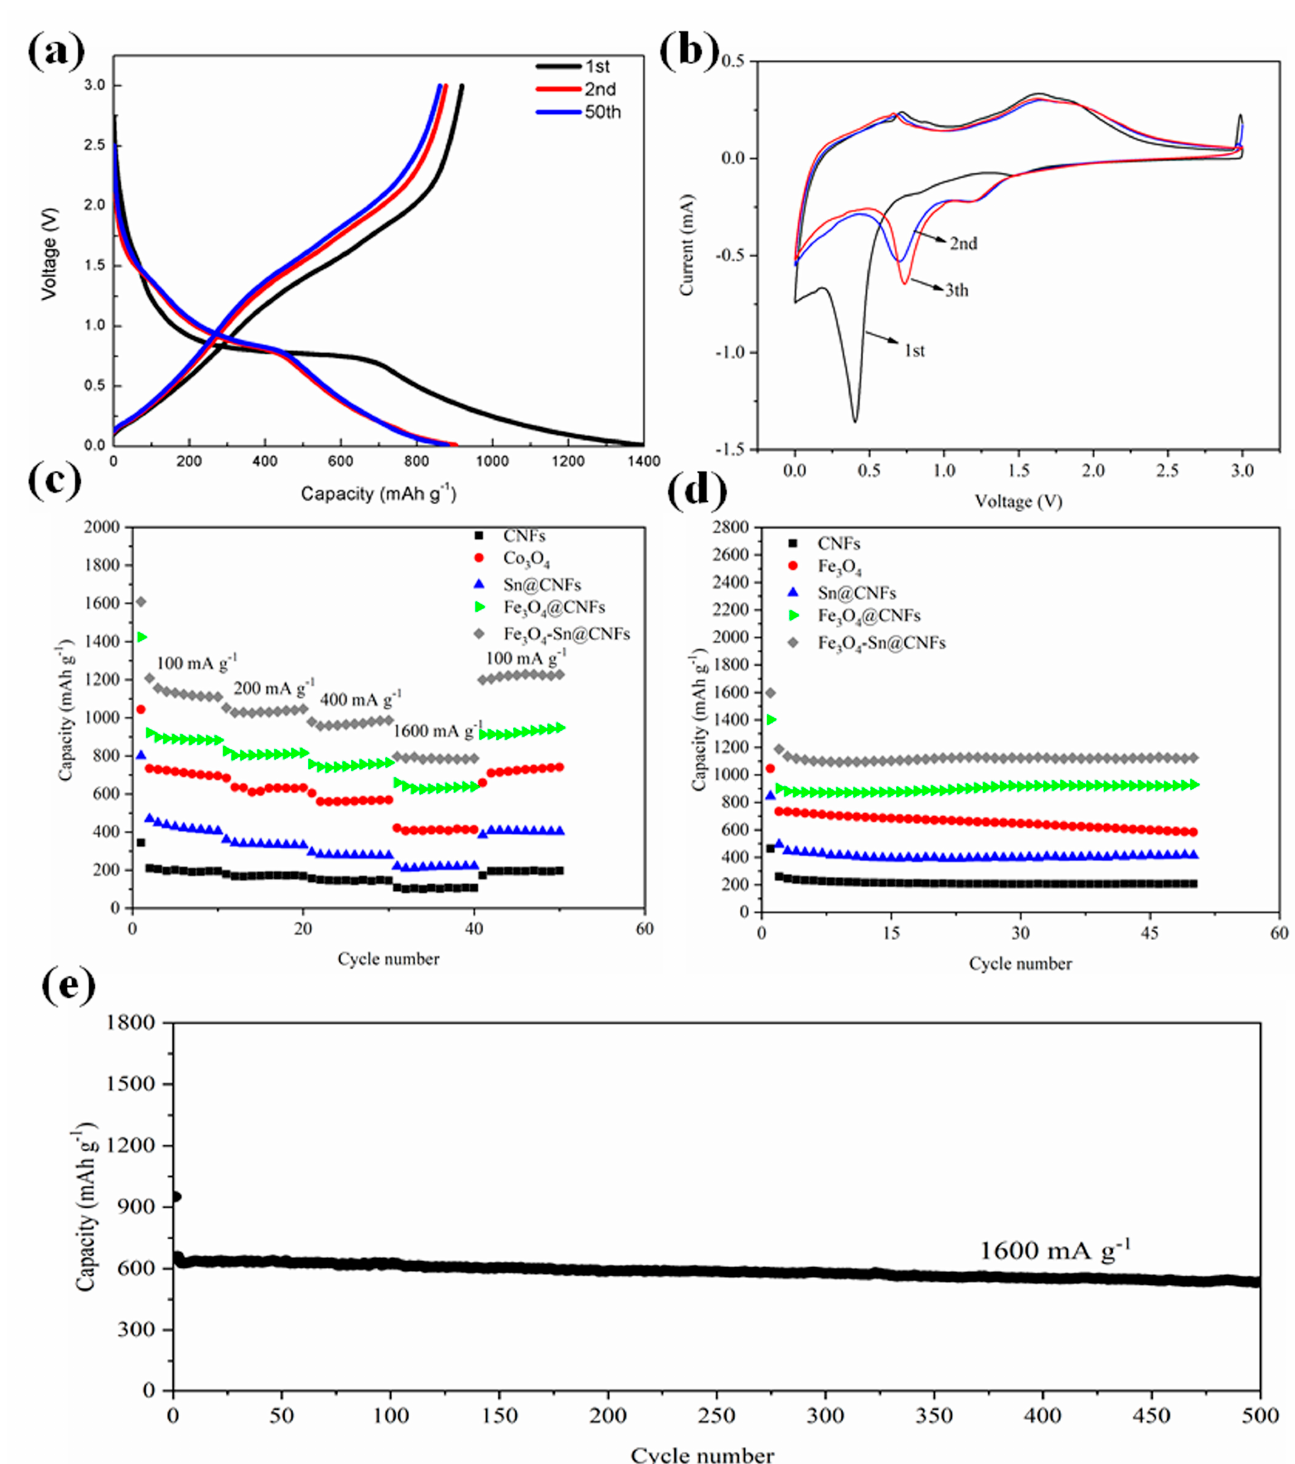
Figure 5. ( a ) Voltage profile of Fe 3 O 4 -Sn@CNFs at 100 mA·g − 1 in 1 M LiPF 6 /EC/DMC. ( b ) Cyclic voltammetry curves of Fe 3 O 4 -Sn@CNFs at 0.2 mV/s scan rate in 1 M LiPF 6 /EC/DMC. ( c ) Rate performance of CNFs, Sn@CNFs, Fe 3 O 4 ,